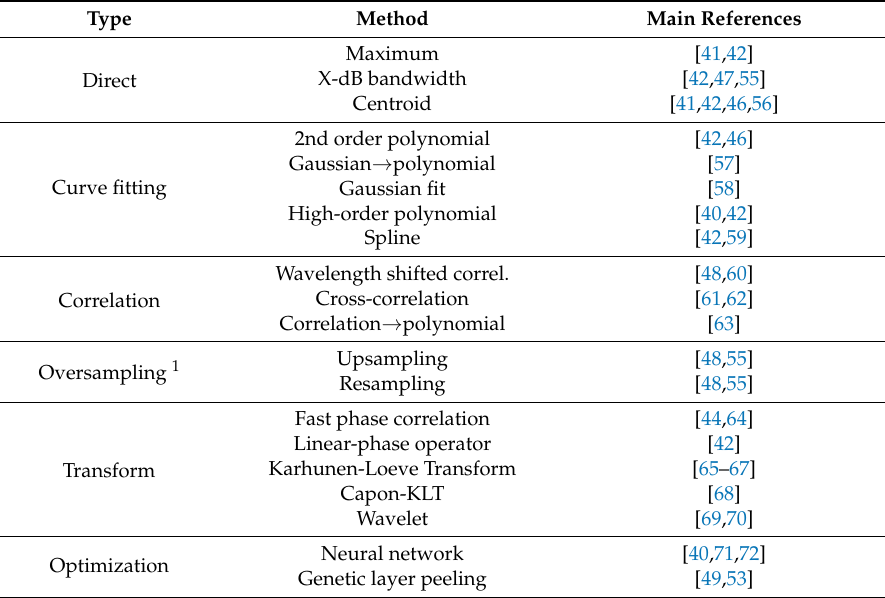
Table 1. List of peak-tracking techniques reviewed in Section